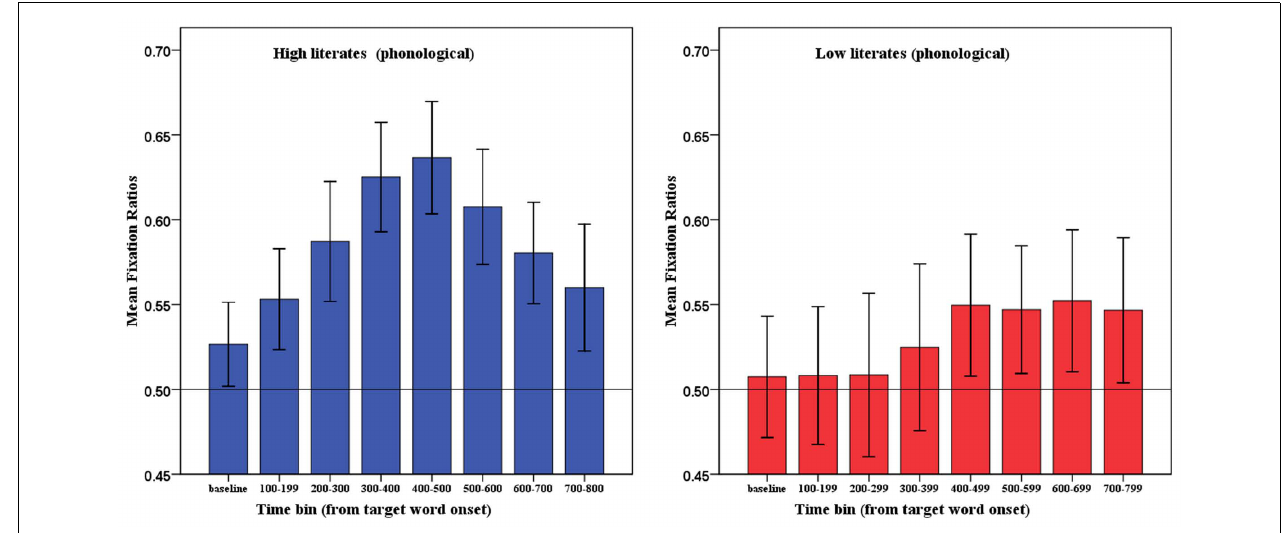
FIGURE 6 | Mean fixation ratios in Experiment 2 . Error bars represent 95% confidence intervals.